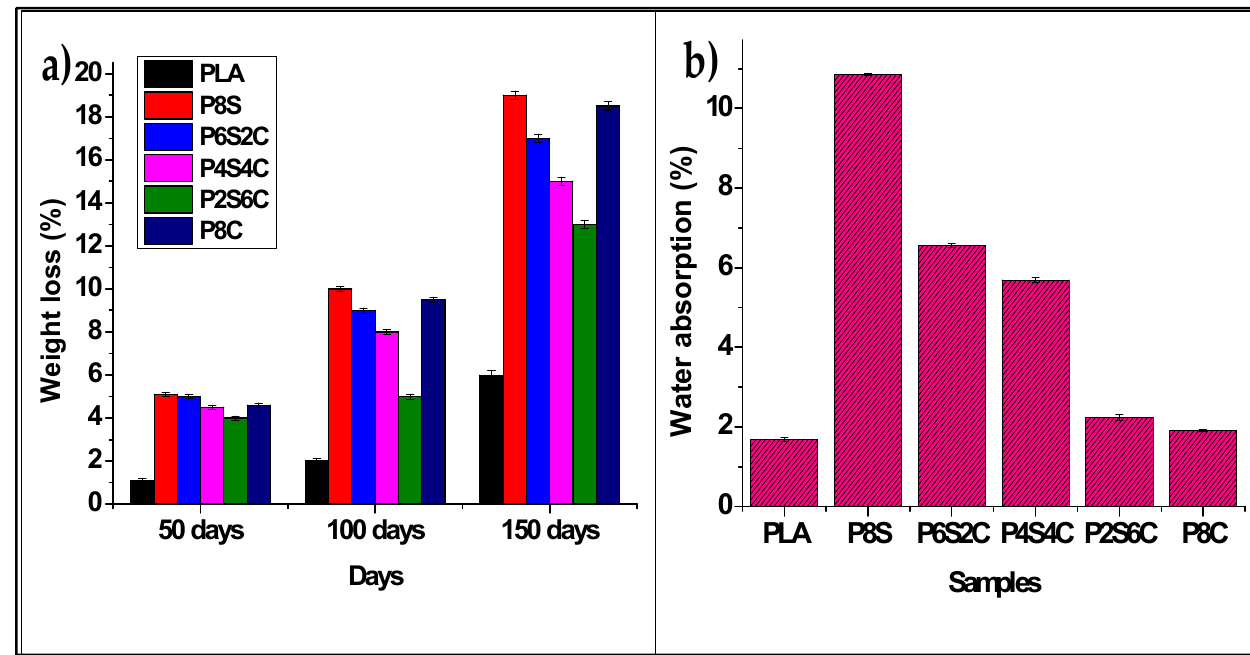
Figure 12. ( a ) Biodegradability and ( b ) water absorption tests of the biocomposite. The neat PLA showed 1.1 ± 0.1%, 2.0 ± 0.11%, and 6.0 ± 0.2% weight loss at 50, 100